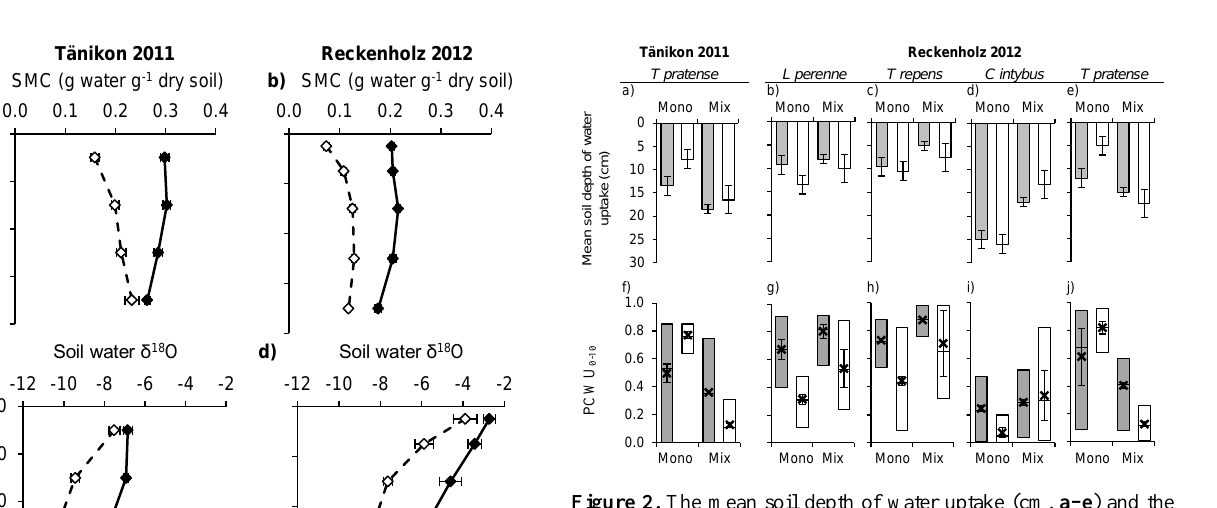
Figure 2. The mean soil depth of water uptake (cm, a–e ) and the proportional contribution to plant water uptake of the 0–10cm soil depth interval (PCWU 0 − 10 ) (f–j) of the two shallow-rooting ( L. perenne and T. repens ) and deep-rooting ( C. intybus and T. pratense ) species grown in monoculture (Mono) or mixture (Mix) under con- trol (shaded bars) or drought (white bars) conditions in Tänikon (2011) ( T. pratense only) and Reckenholz (2012). The mean soil depth of water uptake is based on the direct inference approach (see Fig. S1 in the Supplement). The proportional contribution to plant water uptake (f–j) is based on the frequency distribution output from the IsoSource model and lower, middle and upper boundaries of the bars represent the 1st percentile, 50th percentile and 99th per- centile of the proportional contribution, respectively (see Fig. S2 in the Supplement for all soil depth intervals). The mean ( × ) and SE of the mean proportional contribution are also included ( n = 2 in all cases except for the Tänikon T. pratense control mixture and the Reckenholz T. repens control mixture, where n =